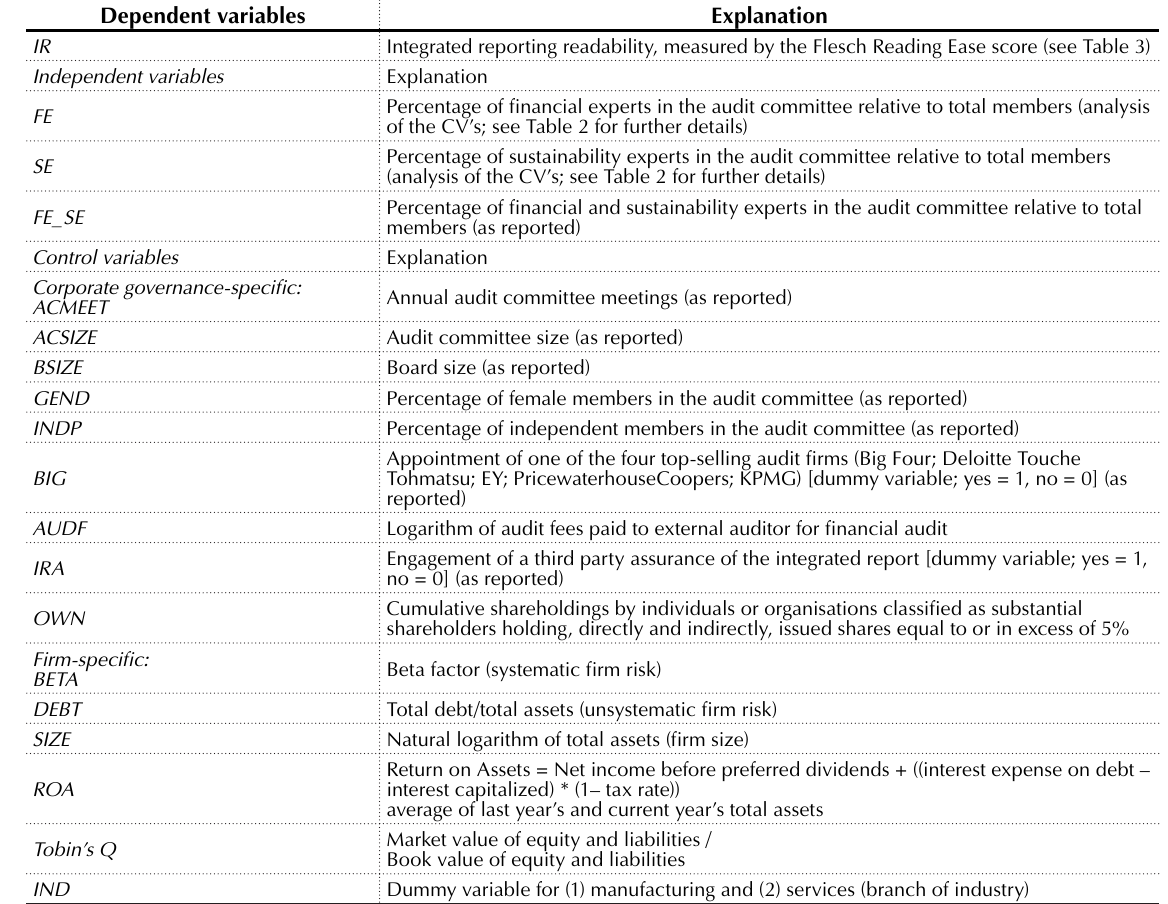
Table 4. Variables of the study Dependent